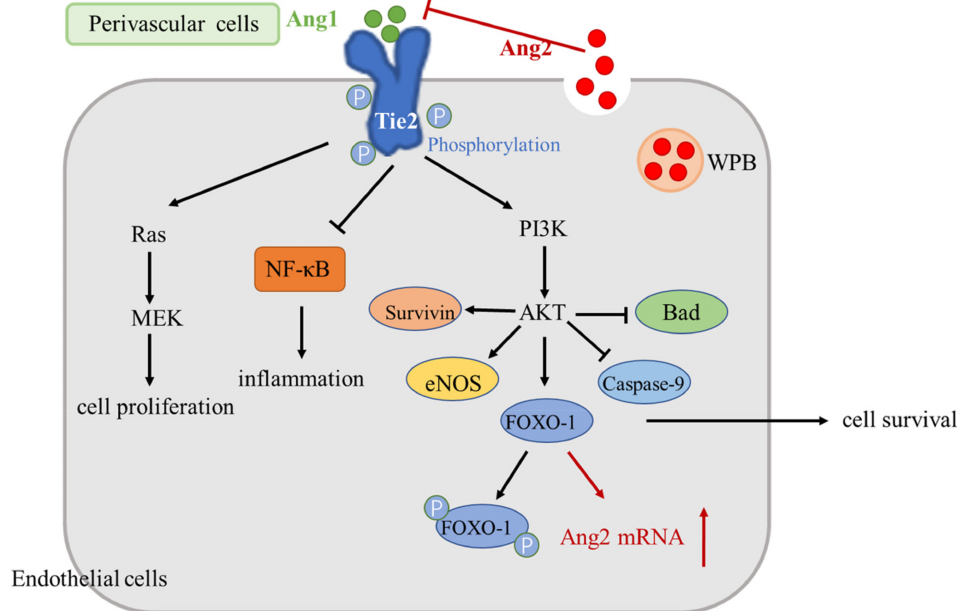
Figure 2. Angiopoietin signaling pathway. When Ang1 binds to Tie2, Tie2 auto-phosphorylates. Tie2 receptors regulate downstream signaling pathways, such as PI3K/AKT, MAPK)/ERK (also known as Ras/Raf/MEK/ERK), Survivin, and eNOS, and inhibits Caspase-9 and Bad, among others. These pathways are involved in reducing angiogenesis and vascular permeability, favoring vascular stability. Following Tie2 activation, FOXO-1 is phosphorylated and inactivated, thereby, promoting endothelial cell quiescence, survival, and vascular stability. In addition, the phosphorylation of Tie2 also prevents NF- κ B signaling activation. In activated endothelial cells, Ang2 is released from endothelial Weibel–Palade bodies. It will antagonize Ang1–Tie2 signaling and inhibit Tie-2 phos- phorylation, leading to vascular instability, vascular leakage, inflammation, etc., thereby promoting angiogenesis. Under these conditions, the FOXO-1 transcription factor is activated and promotes the transcription of Ang2 mRNA, further promoting vascular destabilization. Ang, Angiopoietin; and WPB, Weibel–Palade